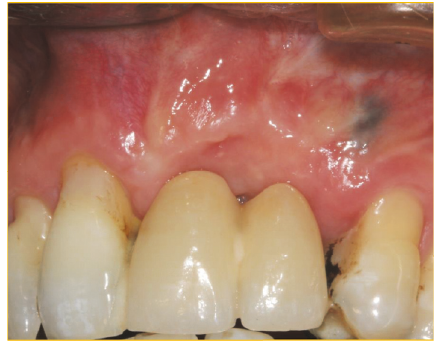
Figure 15: Surgical site 8 months